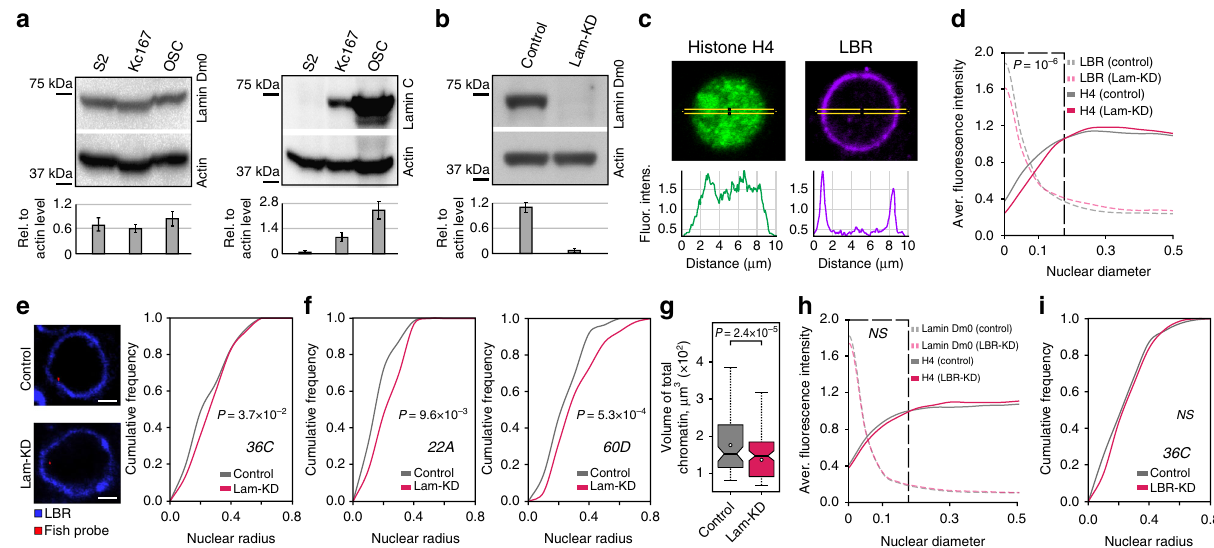
Fig. 1 Chromatin is released from the NE and becomes denser upon Lam-KD in S2 cells. a , b Western-blot analysis of lamin Dm0 and lamin C protein levels in Drosophila cell lines ( a ), or in Lam-KD and control S2 cells ( b ). Band intensity quantitation is presented below. c A representative example of nuclei immunostained with antibodies against histone H4 and LBR. Fluorescence intensity along the yellow-framed zone was measured using ImageJ software. d Averaged fl uorescence intensity pro fi les along the nuclear diameter in Lam-KD ( n = 120) and control ( n = 180) S2 cells immunostained with antibodies against histone H4 and LBR. P value for the framed region of histone H4 pro fi les was estimated in a Wilcoxon test. e Cumulative frequency of radial positions of the FISH probe located in the LAD from cytological region 36C in Lam-KD ( n = 175) or control ( n = 175) S2 cells (right panel). P value was estimated in a Kolmogorov-Smirnov one-sided test. Representative examples of FISH signals in nuclei stained with anti-LBR antibody are shown on the left panels. Scale bar 1 µ m. f Cumulative frequency of radial positions of FISH probes to cytological regions 22A (left) or 60D (right) in Lam-KD ( n = 100 for 22A and n = 99 for 60D ) or control ( n = 115 for 22A and n = 72 for 60D ) S2 cells. P value was estimated in a Kolmogorov-Smirnov one-sided test. Data for analysis were taken from ref. 11 . g Total chromatin volume measured by DAPI fl uorescence in Lam-KD ( n = 125) or control ( n = 83) S2 cells. P value was estimated in a Wilcoxon test. Thick black lines and white dots represent median and average values, upper and lower ends of boxplot show the upper and lower quartiles, the whiskers indicate the maximum and minimum values. h Averaged fl uorescence intensity pro fi les along the nuclear diameter in LBR-depleted (LBR-KD, n = 120) or control ( n = 120) S2 cells immunostained with antibodies against histone H4 and lamin Dm0. NS – non-signi fi cant difference ( P > 0.05, Wilcoxon test). i Cumulative frequency of radial positions of the FISH probe to cytological region 36C in LBR-KD ( n = 150) or control ( n = 150) S2 cells. NS – non-signi fi cant difference ( P > 0.05, Kolmogorov-Smirnov one-sided test)